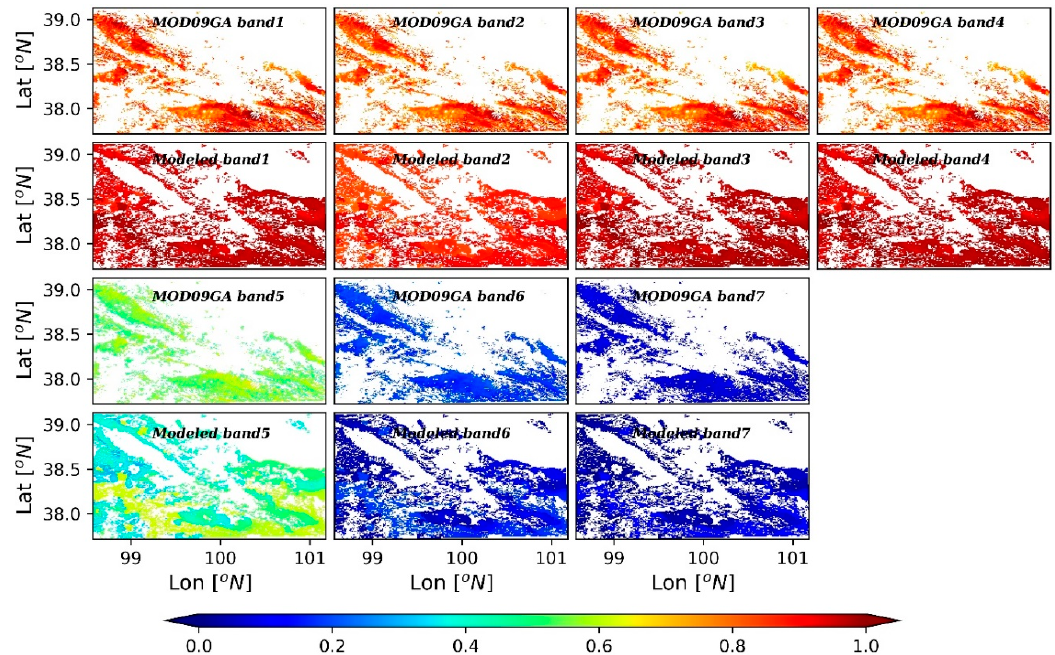
Figure 8. Comparison between the narrowband snow albedo retrieved from MOD09GA reflectance data and the narrowband snow albedo simulated by the integrated model. MOD09GA band: retrieved narrowband snow albedo based on MOD09GA reflectance data. Modeled band: simulated narrowband snow albedo by the integrated model. The integrated model simulation results and remote sensing observation results are compared at the same time.